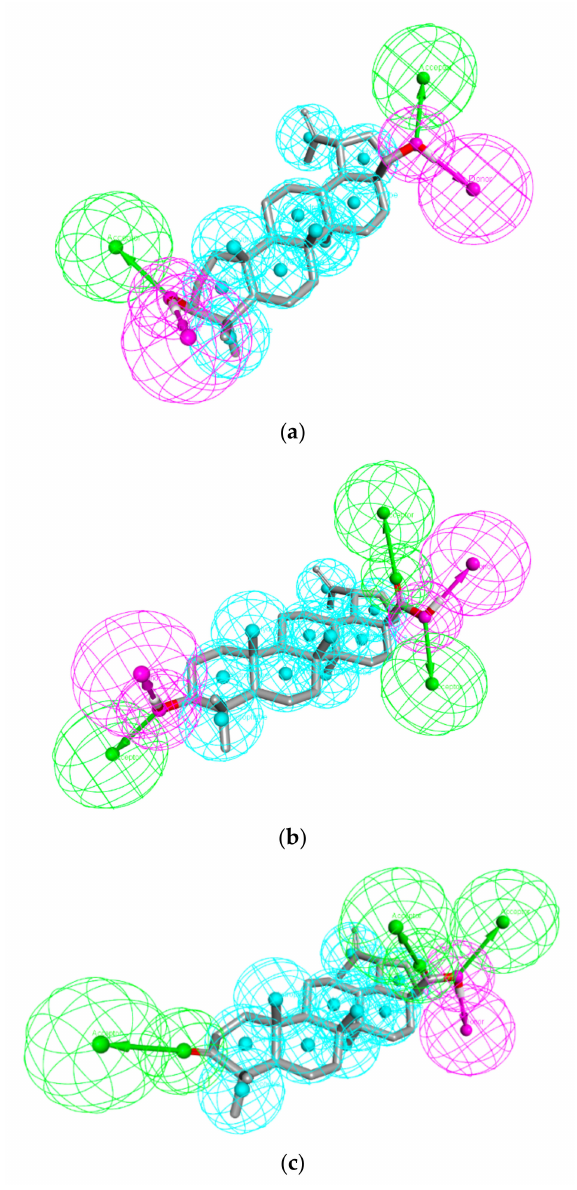
Figure 1. Pharmacophore models for ( a ) betulin, ( b ) betulinic, and ( c ) betulonic acids. Color code: cyan = hydrophobic; green = H-acceptor; purple =